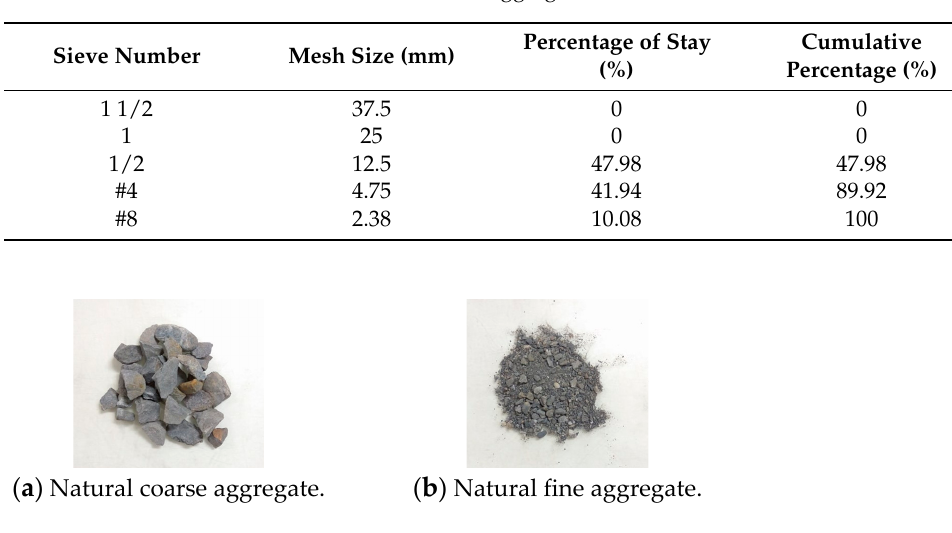
Table 3. Physical properties of natural fine aggregate.